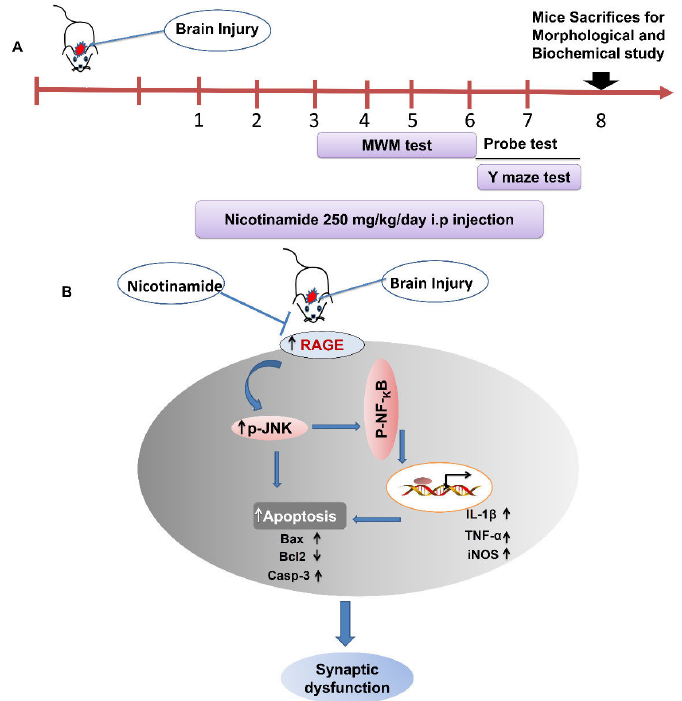
Figure 1. The schematic diagram represents the treatment schedule and the mechanism of NAM neuroprotection in mouse brains. The schematic representation ( A ) showing that NAM was treated for 7 days following the brain injury in mice and ( B ) showing that NAM treatment for 7 days ameliorated neuroinflammation, neuronal apoptosis, and rescued memory impairment via regulation of RAGE/JNK/NF-KB signaling pathway after mouse brain